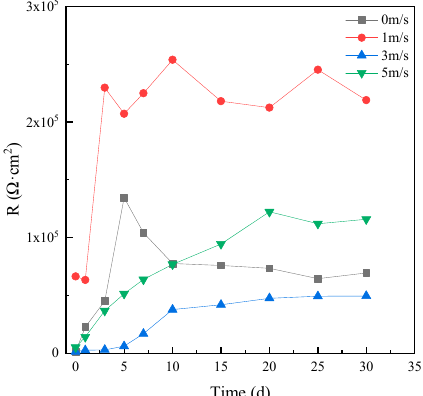
Figure 10. Corrosion resistance of WZ in different flowing seawater varying with time.